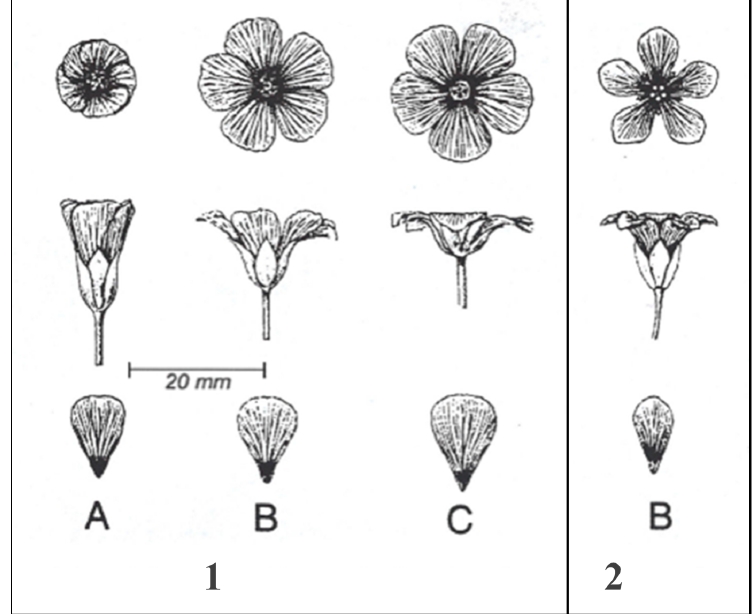
Figure 5. Shape of flowers in flax: ( A ) tube, ( B ) funnel, and ( C ) bowl; ( 1 ) petals overlap more than 50% and ( 2 ) petals overlap less than 50% (figure and scale adapted from Diederichsen and Richards, (2003)) [38].